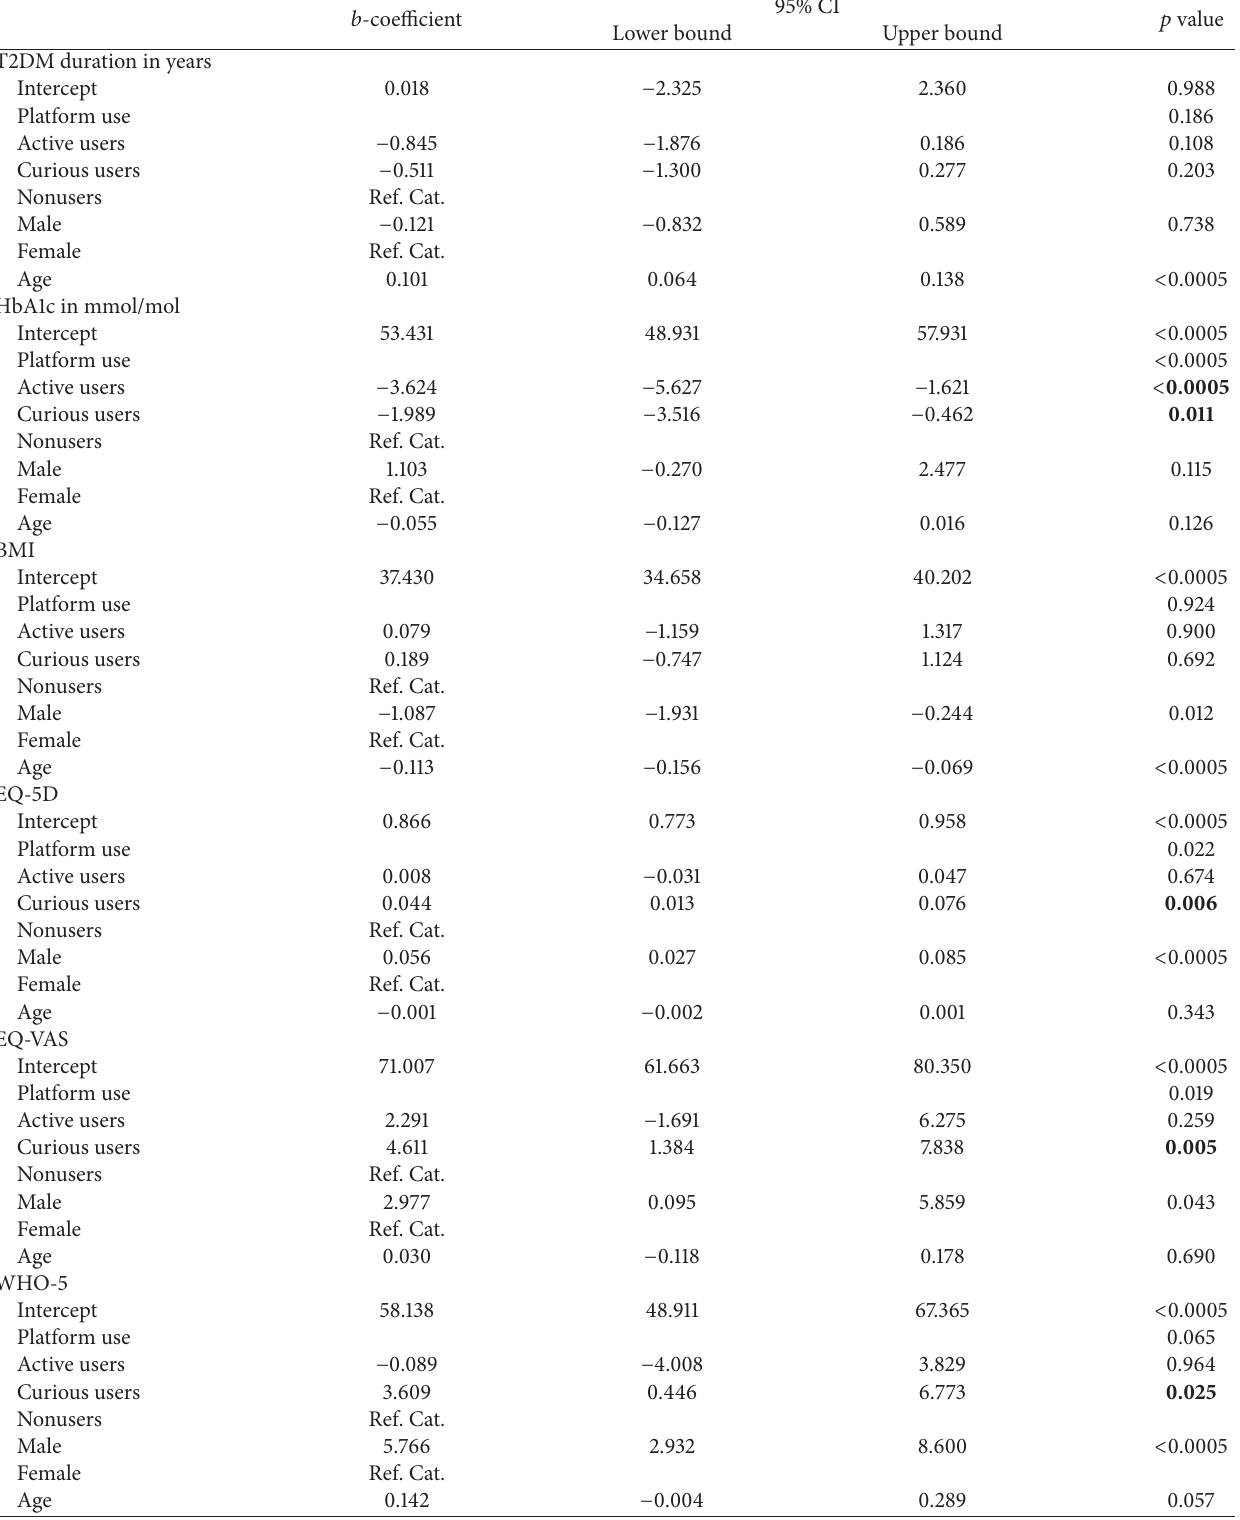
Table 3: Results of multivariate analysis, adjusted for age and